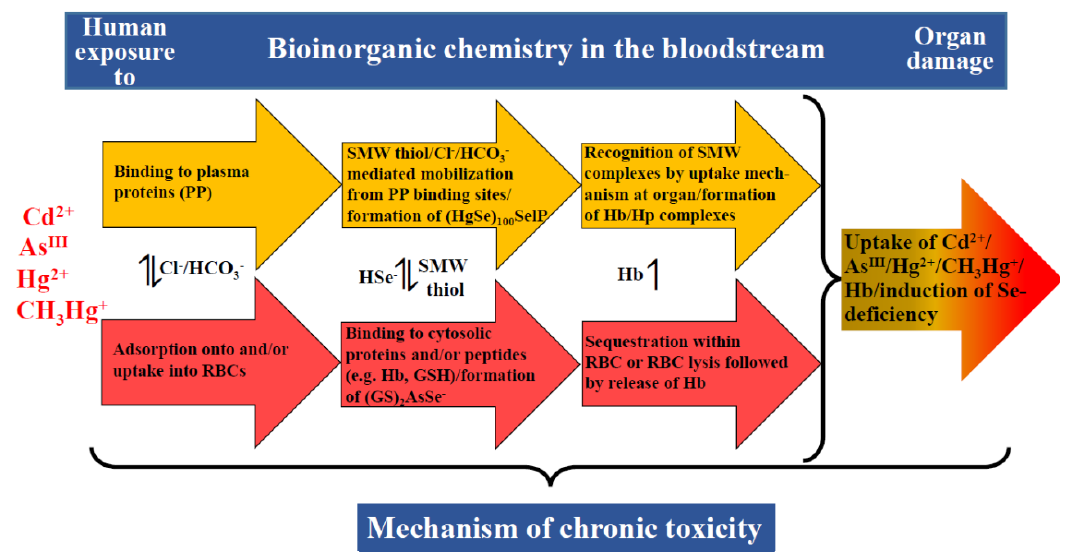
Figure 3. Bioinorganic chemistry of toxic metal(loid) species that unfold in plasma (yellow) and red blood cells (red) are critical to establish their mechanism of chronic toxicity, which determines the degree of organ damage over weeks/months/years. Abbreviations: red blood cells (RBC), small molecular weight (SMW), hemoglobin (Hb), selenoprotein P (SelP), haptoglobin (Hp), glutathione